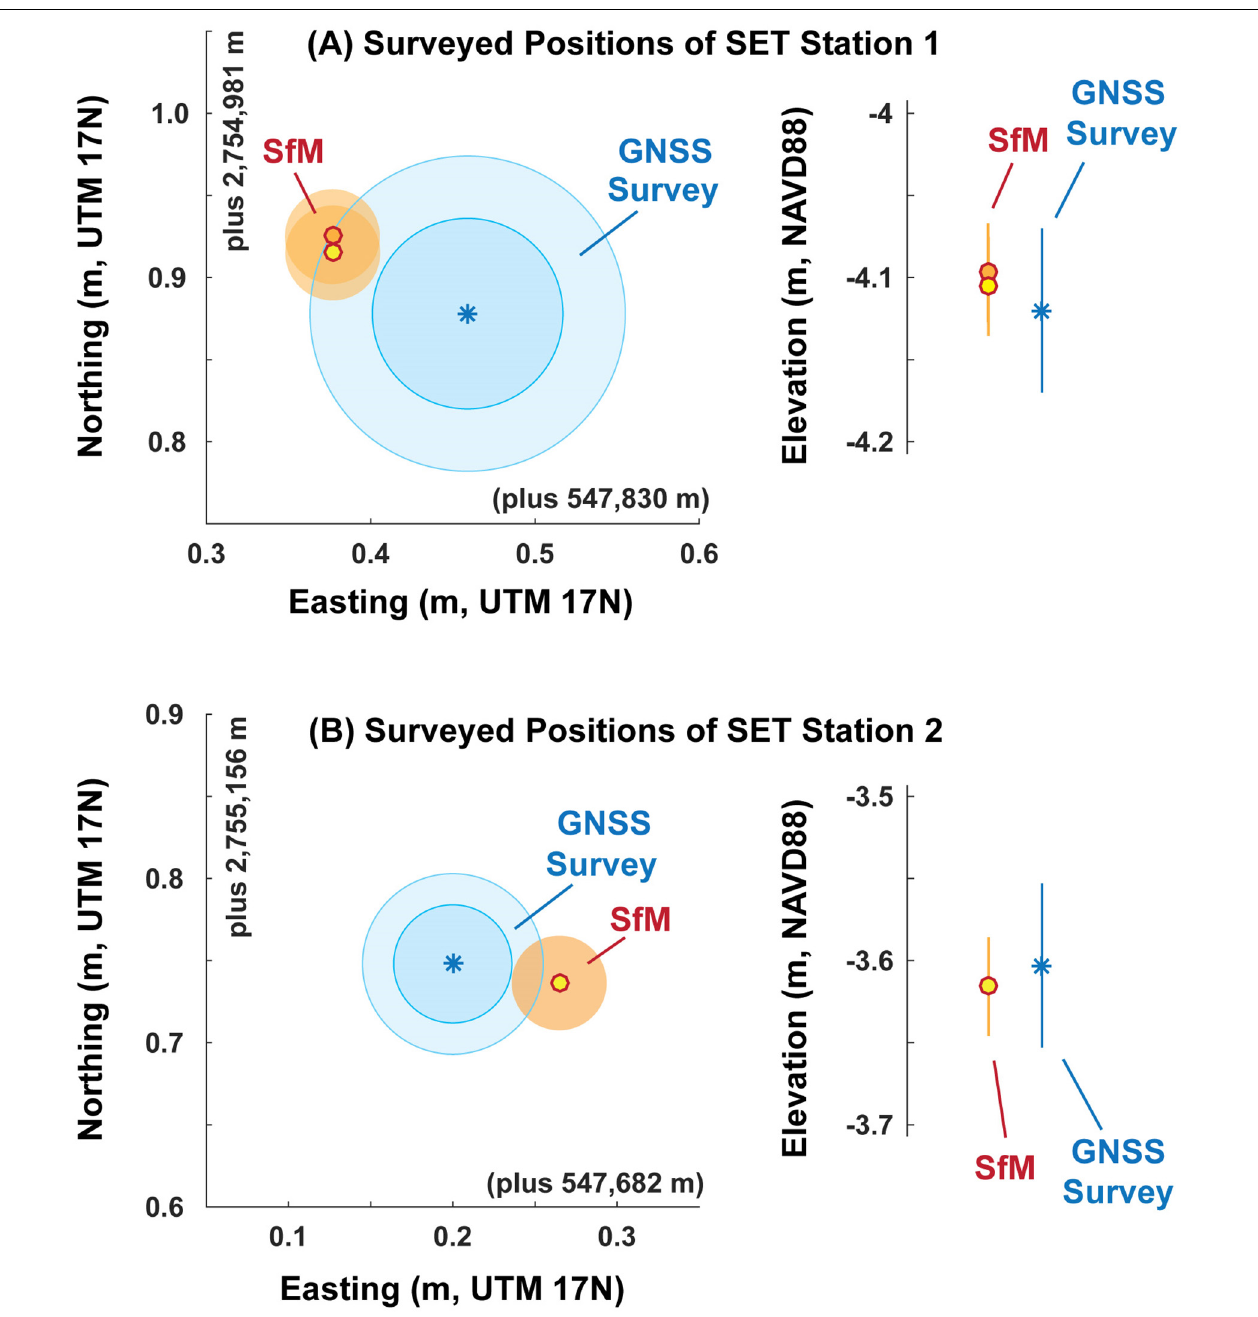
FIGURE 9 | Comparison of the measured positions of the Surface Elevation Table (SET) stations 1 and 2 (shown in A,B respectively) from field-based Global Navigation Satellite System (GNSS) and Structure-from-Motion (SfM) with the SQUID-5 system. Greater uncertainty exists for the GNSS measurements owing to the leveling techniques during scuba conditions, and both “reasonable” and “max” uncertainties are shown for the GNSS measurements (see Table 1 ). Uncertainty of the SfM measurements assumed to be 3 cm, which is equivalent to the approximate uncertainty of the survey-grade GNSS measurement.